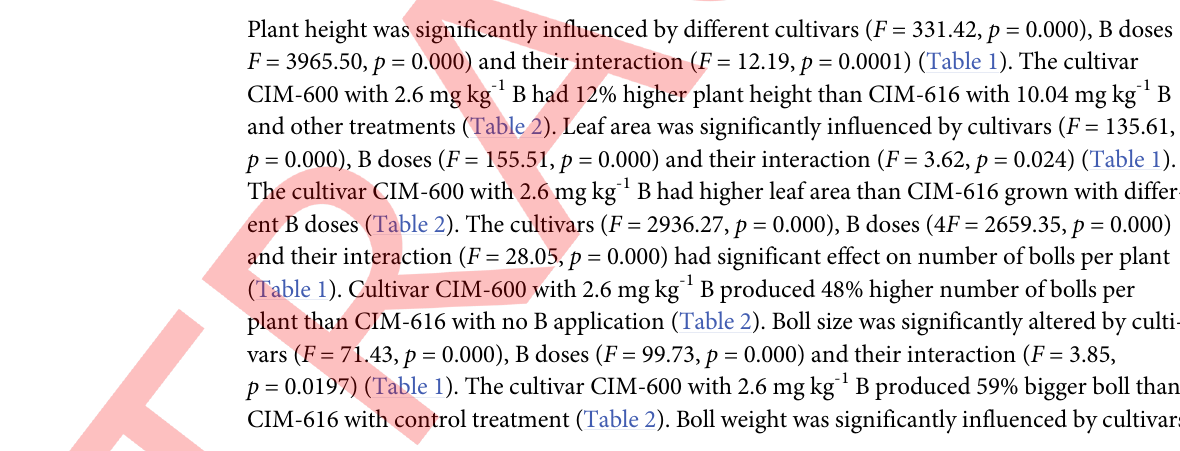
Table 2. Influence of different soil applied boron doses on plant height, leaf area, number of bolls per plant, boll size and weight, and seed-cotton yield of cotton cultivars. B doses (mg kg -1 ) Plant height (cm)